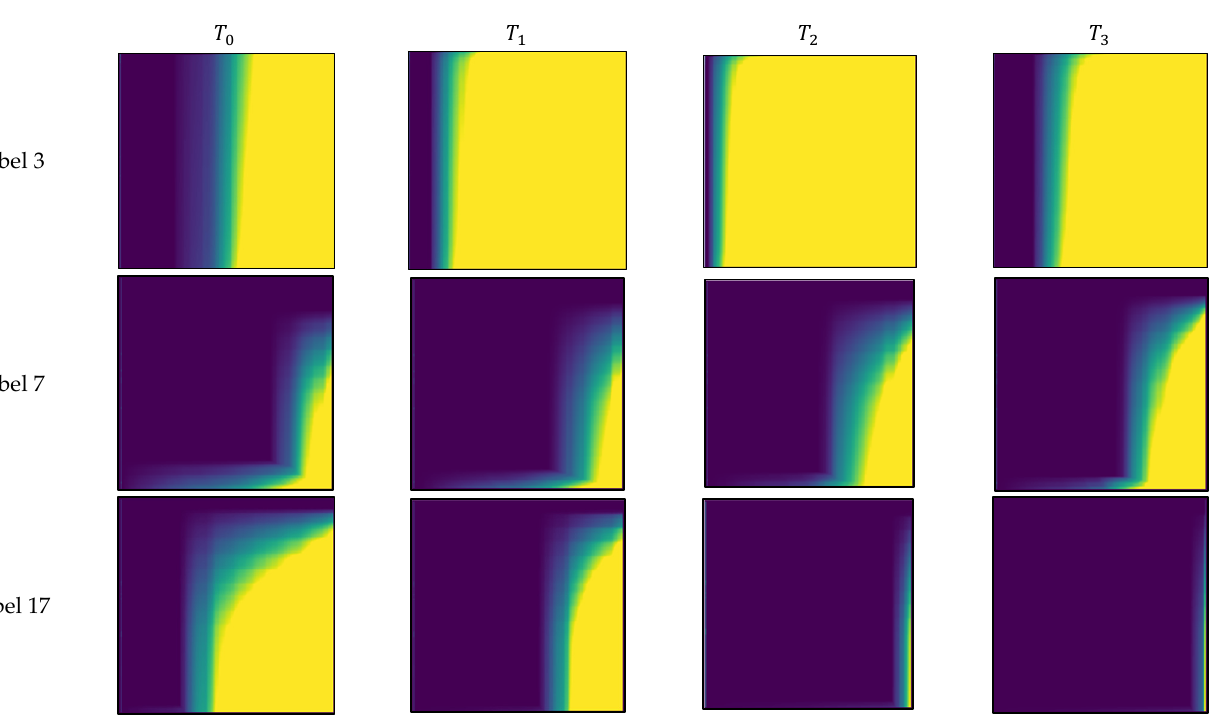
Figure 7. 𝐵𝐼𝐷𝑃 (cid:3006)(cid:2869) examples of 1st enhanced 𝑆𝐵𝐼𝐷𝑃 by sorting elements of the 𝐴(cid:4670)∙(cid:4671) and 𝐺(cid:4670)∙(cid:4671) ma- Figure 7. BIDP E 1 examples of 1st enhanced SBIDP by sorting elements of the A [ · ] and G [ · ] matrices. trices.